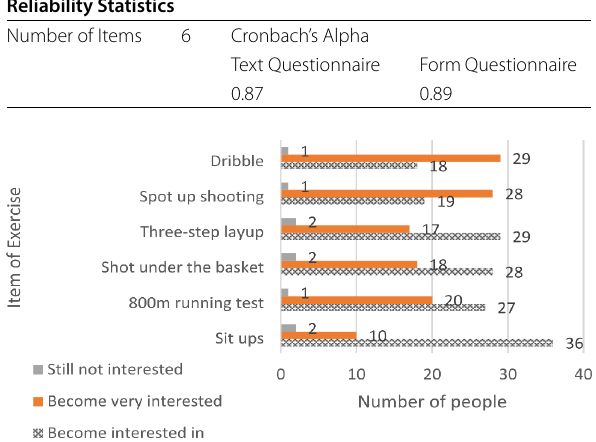
Figs. 8 A comparison of basket shots, three-step layups, and spot-up shots A. Data results before basket shooting, three-step layup and fixed-point shooting training. B. Data results after basket shooting, three-step layup and fixed-point shooting Table 2 Questionnaire reliability table